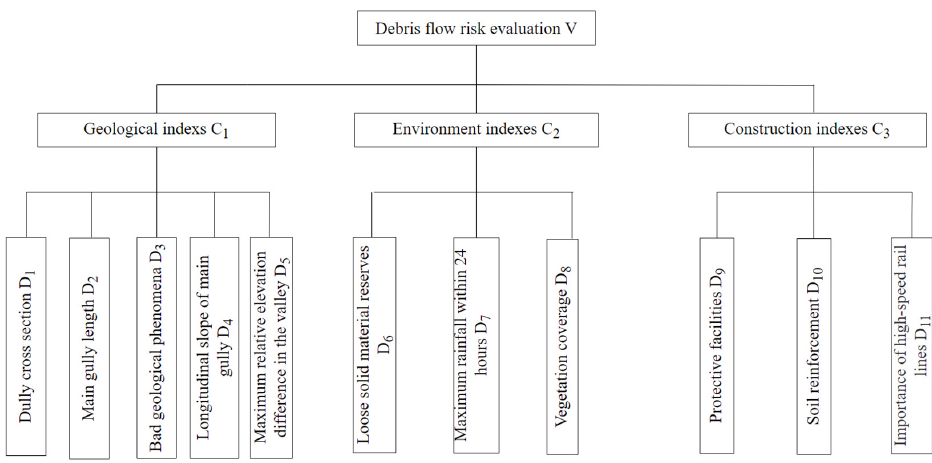
Figure 10. Evaluation index system of debris flow risk in hydropower project.